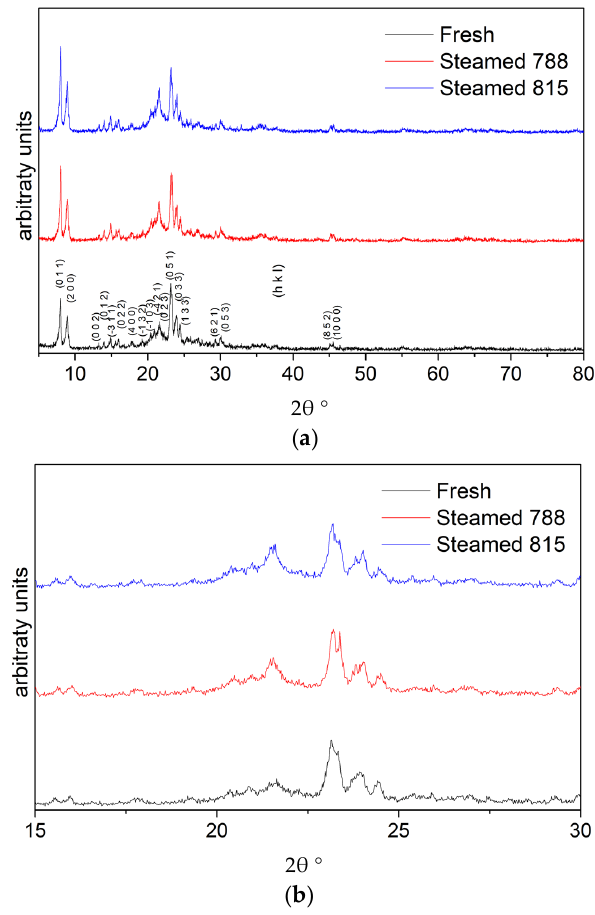
Figure 1. X-ray diffraction (XRD) patterns of the fresh and steamed P/ZSM-5 (at 788 ◦ C and 815 ◦ C for 20 h, 100% steam) additives: ( a ) 5–80 ◦ 2 θ range; ( b ) and 15–30 ◦ 2 θ